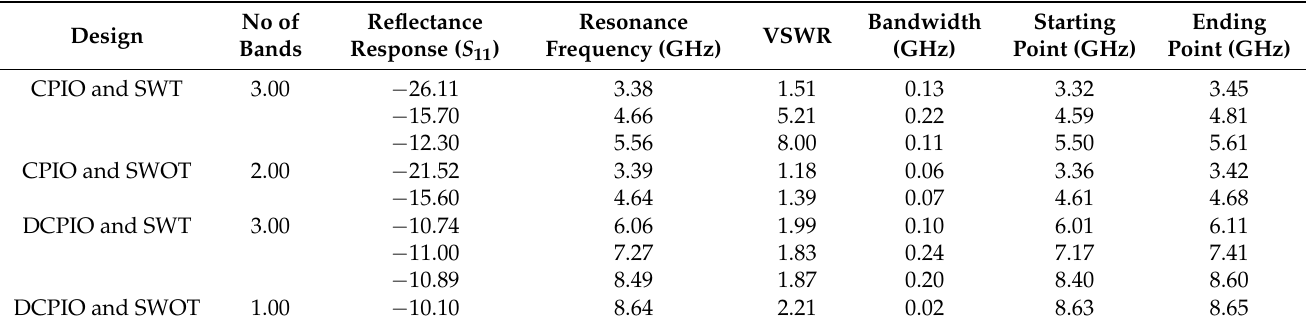
Table 3. Reflectance plot ( S 11 ), total bands, resonance frequency, VSWR, and bandwidth data repre- sentation for the proposed four antenna structures using a substrate of